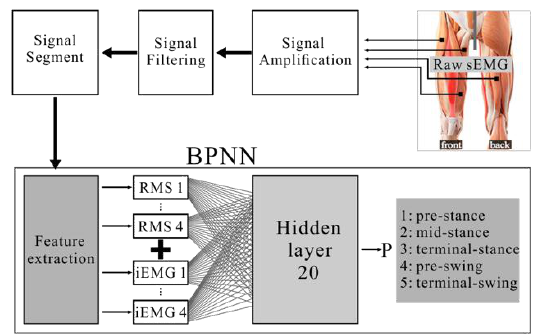
Figure 2. Schematic structure of the BPNN, including 20 nodes in the hidden layer, where eight features were extracted as input from the segmented sEMG signal after amplification, filtering, and segmenting, and the output layer consisted of a single node (phase).